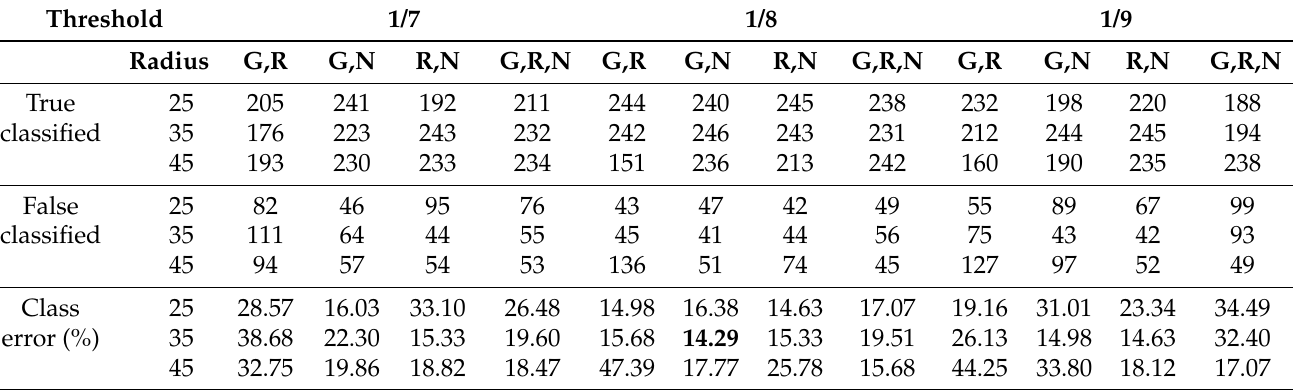
Table 4. The ANN classification results for three threshold limits and three circle radii and various band combinations. Note that G, R, and N are short for Green, Red, and Near-infrared, respectively. Moreover, the circle radius (the second column in this table) is expressed as the number of pixels. The total data tested was 287 for each combination of different